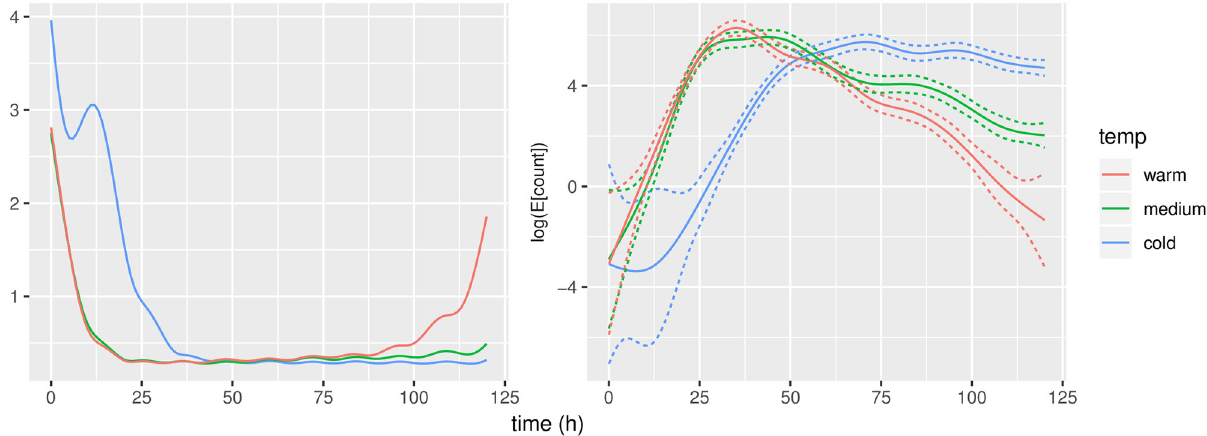
Fig 7. Left: Pointwise evaluations of 1.96 � I − 1 , where I is the information matrix. Right: Corresponding pointwise confidence intervals.